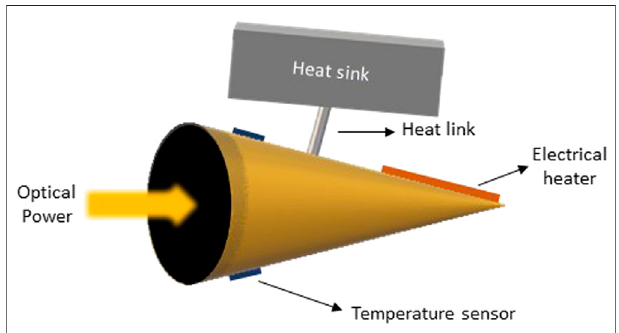
FIGURE 1 | Schematic of an electrical substitution radiometer (ESR).